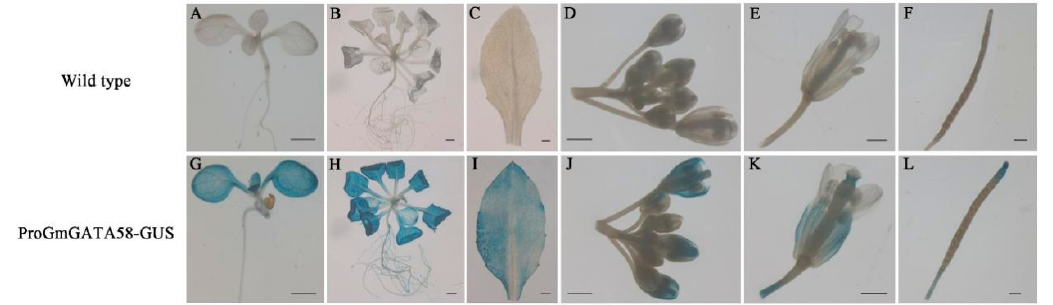
Figure 3. Histochemical GUS assay of transgenic Arabidopsis plants. The wild-type plant ( A – F ) and transgenic plant ( G – L ) carrying GmGATA58 promoter-GUS construct are indicated for GUS staining. Scale bars = 0.1 cm.